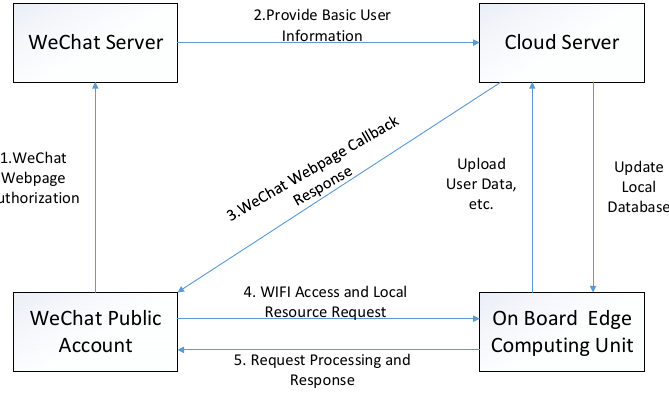
Figure 3. Application software system.